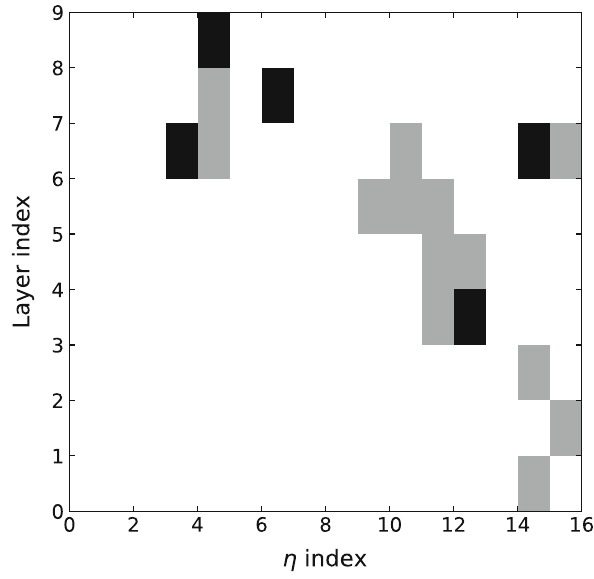
Fig. 4 Same event of Fig. 1 after the Fragmentation procedure described in Sect. 5.1 (muon η small (cid:2) 0 . 88). The black (grey) pix- els of the bottom image represent the result of two (one) turned-on contiguous pixels after the Average-Pooling